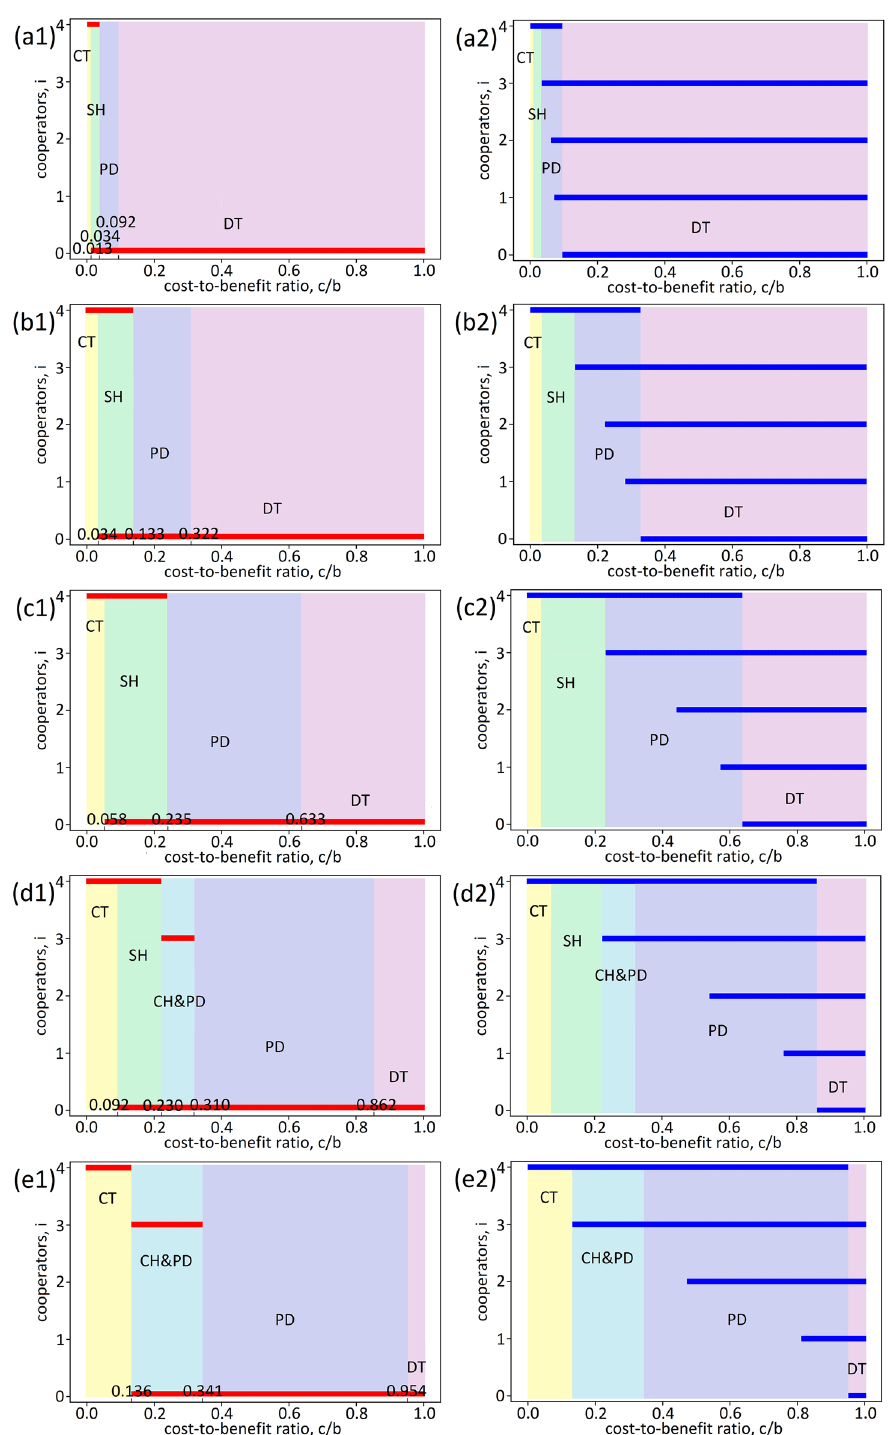
Figure 2. Equilibria and optimal strategies of the four-player weightlifting game. Nash equilibria ( a1 , b1 , c1 , d1 , e1 ) and Pareto optimal strategies ( a2 , b2 , c2 , d2 , e2 ). ( a1 , a2 ) µ = 10 . ( b1 , b2 ) µ = 20 . ( c1 , c2 ) µ = 30 . ( d1 , d2 ) µ = 40 . ( e1 , e2 ) µ = 50 . The parameter regions for Nash equilibria and Pareto optimal strategies are as hatched in the i - c / b plane, where i is the number of cooperators and c / b is the cost-to-benefit ratio. We set σ = 50 in all cases. All players cooperate for a small value of c / b (CT), while they defect for a large value